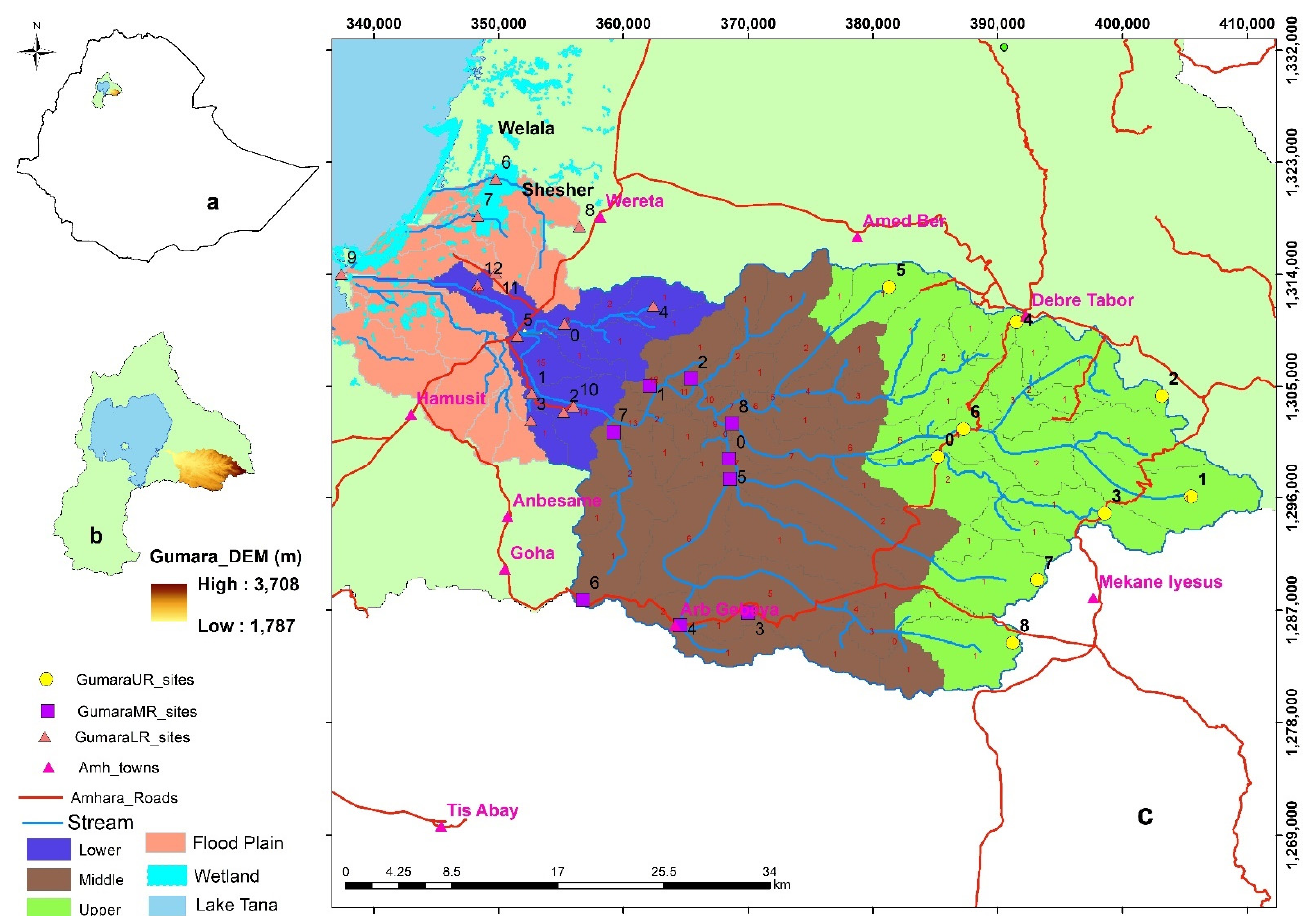
Figure 1. Location and sampling sites in the three reaches of Gumara River. ( a ) Ethiopia, ( b ) Lake Tana sub-basin, ( c ) Gumara watershed divided into three reaches (lower in blue, middle in brown, and upper in light green), associated flood plain wetlands (Welala and Shesher), and the Lake [16]. The numbers indicate the different sampling sites and are described in the Supplemental Materials (Table S1).